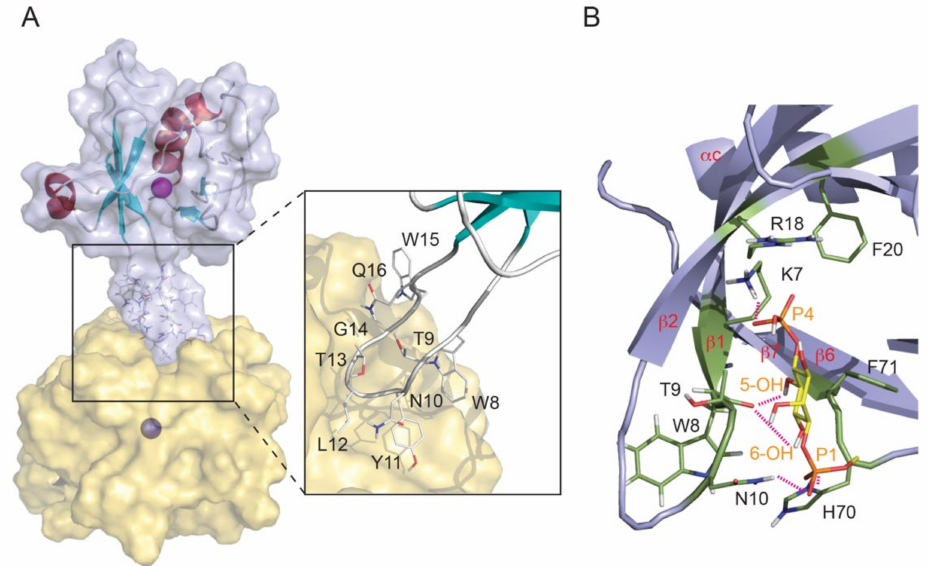
Figure 6. Structure of the PH domain of FAPP1 docked to a PI4P-containing micelle. ( A ) The backbone of the structure (PDB: 2MDX) is grey, helices and β -strands are shown in aqua and red, respectively, under a translucent silver molecular surface and the dodecylphosphocholine micelle is gold. The protein and micelle centres are marked with magenta and blue dots, respectively, and 40 Å apart. The β 1– β 2 loop residues that insert into the micelle are labelled. ( B ) The bound inositol ring and 1- and 4-phosphates are colored yellow and orange, respectively. Intermolecular hydrogen bonds are depicted as dashed lines to the sidechains of the labelled residues. Used by permission from